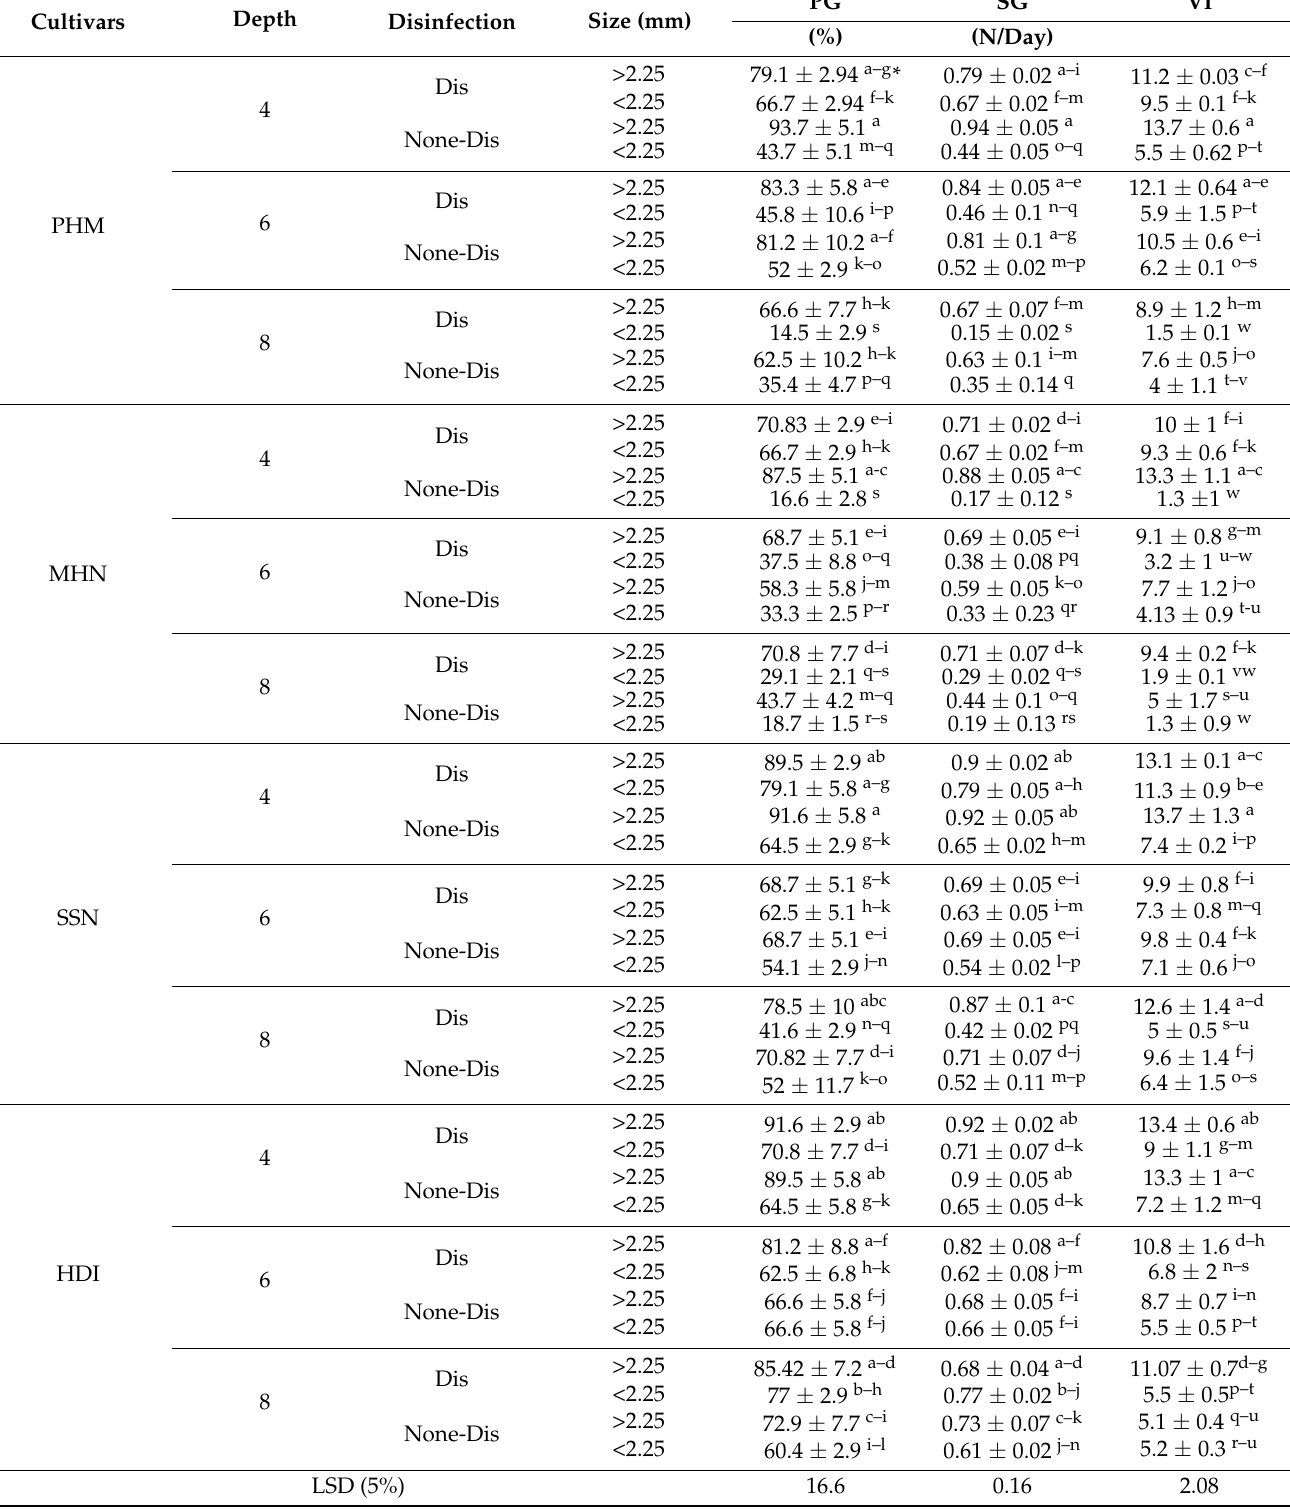
Table 4. Effect of depth of sowing, disinfection, and seed size upon the percentage of germination, speed of seed germination, and vigor index in different